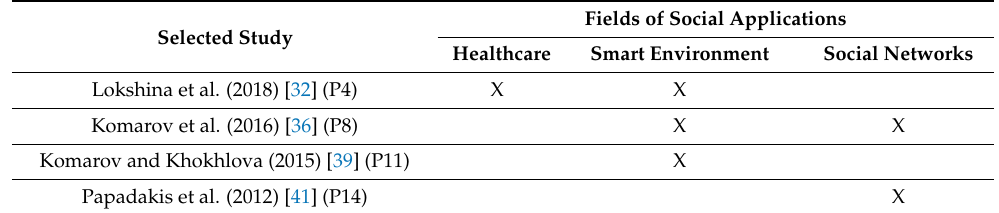
Table 5. Selected studies by field of social application.